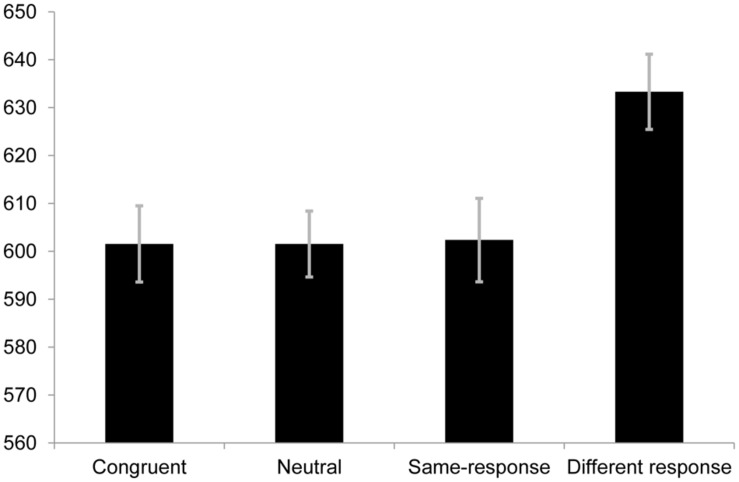
Mean RTs (in ms) for each condition in Experiment 2A. Error bars represent SE.